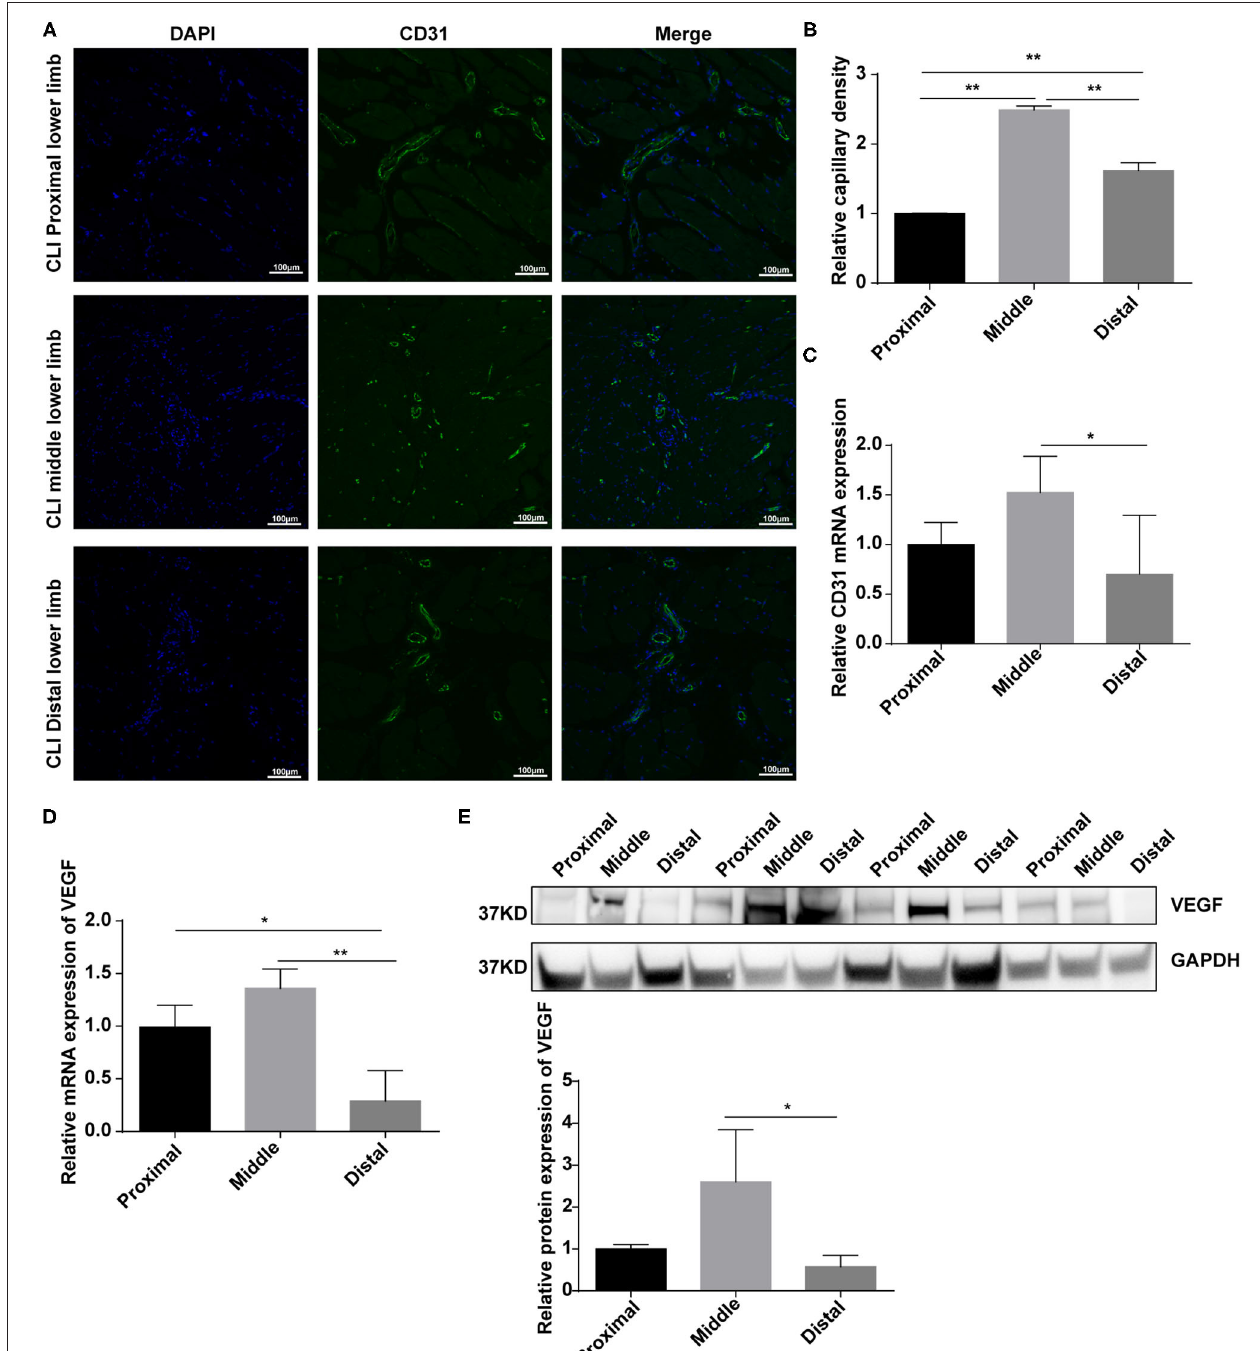
FIGURE 4 | Angiogenesis are elevated in response to vascular occlusion in the lower limb muscle of critical limb ischemia (CLI) patients. (A,B) Immunofluorescence conducted in the lower limb muscle of CLI patients with specific anti-CD31 antibody. Relative capillary density was determined based on immunofluorescence staining. Data are presented as mean ± SEM ( n = 9, one-way ANOVA with post-hoc Tukey test). ** p < 0.01, middle lower limb vs. proximal lower limb; ** p < 0.01, distal lower limb vs. proximal lower limb; ** p < 0.01, distal lower limb vs. middle lower limb. (C) Relative mRNA expression of CD31 in the lower limb muscle of CLI patients by real-time PCR. Data are presented as mean ± SEM ( n = 9, one-way ANOVA with post-hoc Tukey test). * p < 0.05 middle lower limb vs. proximal lower limb; * p < 0.05 distal lower limb vs. middle lower limb. (D) Relative mRNA expression of VEGF in the lower limb muscle of CLI patients by real-time PCR. Data are presented as mean ± SEM ( n = 9, one-way ANOVA with post-hoc Tukey test). ** p < 0.01 distal lower limb vs. middle lower limb; * p < 0.05 distal lower limb vs. proximal lower limb. (E) Relative protein expression of VEGF in the lower limb muscle of CLI patients by western blot ( n = 4, one-way ANOVA with post-hoc Tukey test). Data are presented as mean ±